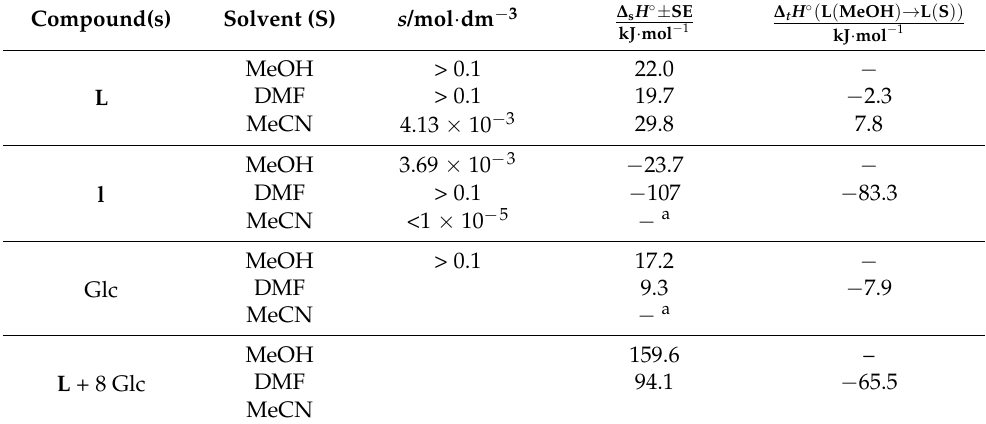
Table 3. Solubilities and dissolution enthalpies of compounds L , l , and Glc at 25 ◦ C in examined solvents. Compound(s) Solvent